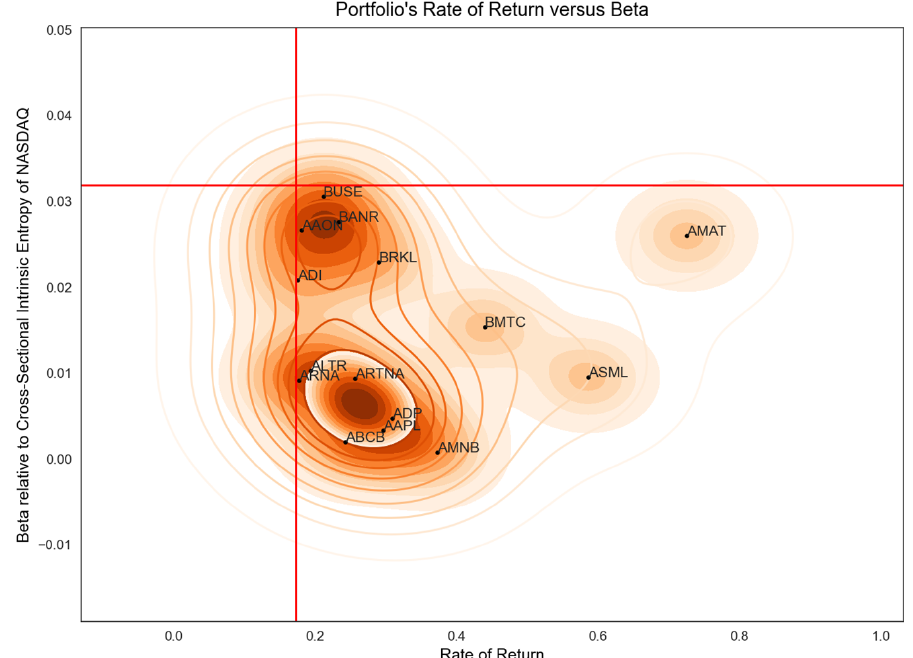
Figure 5. A set of 15 NASDAQ symbols that outperformed the NASDAQ Composite index in terms of rate of return without being exposed to higher risk (250-day trading interval, from 5 October 2020 to 20 December 2021).